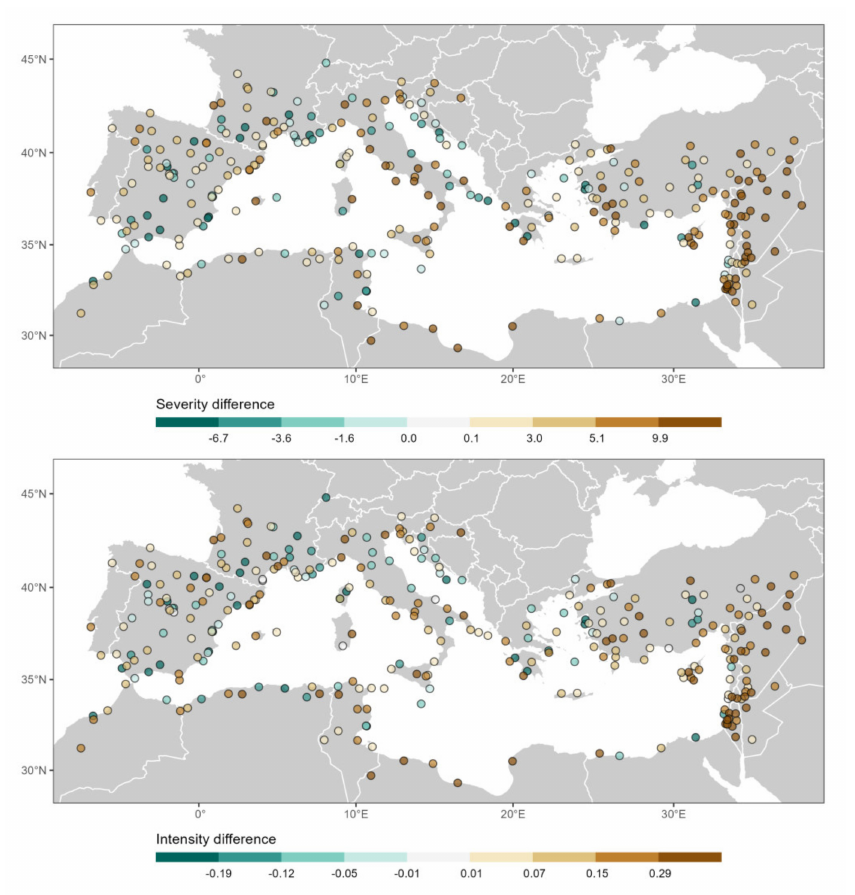
Figure 5. Difference of average severity of drought events (DRS) and average intensity drought events (DRI) between 1975–1996 and 1997–2019 according to the